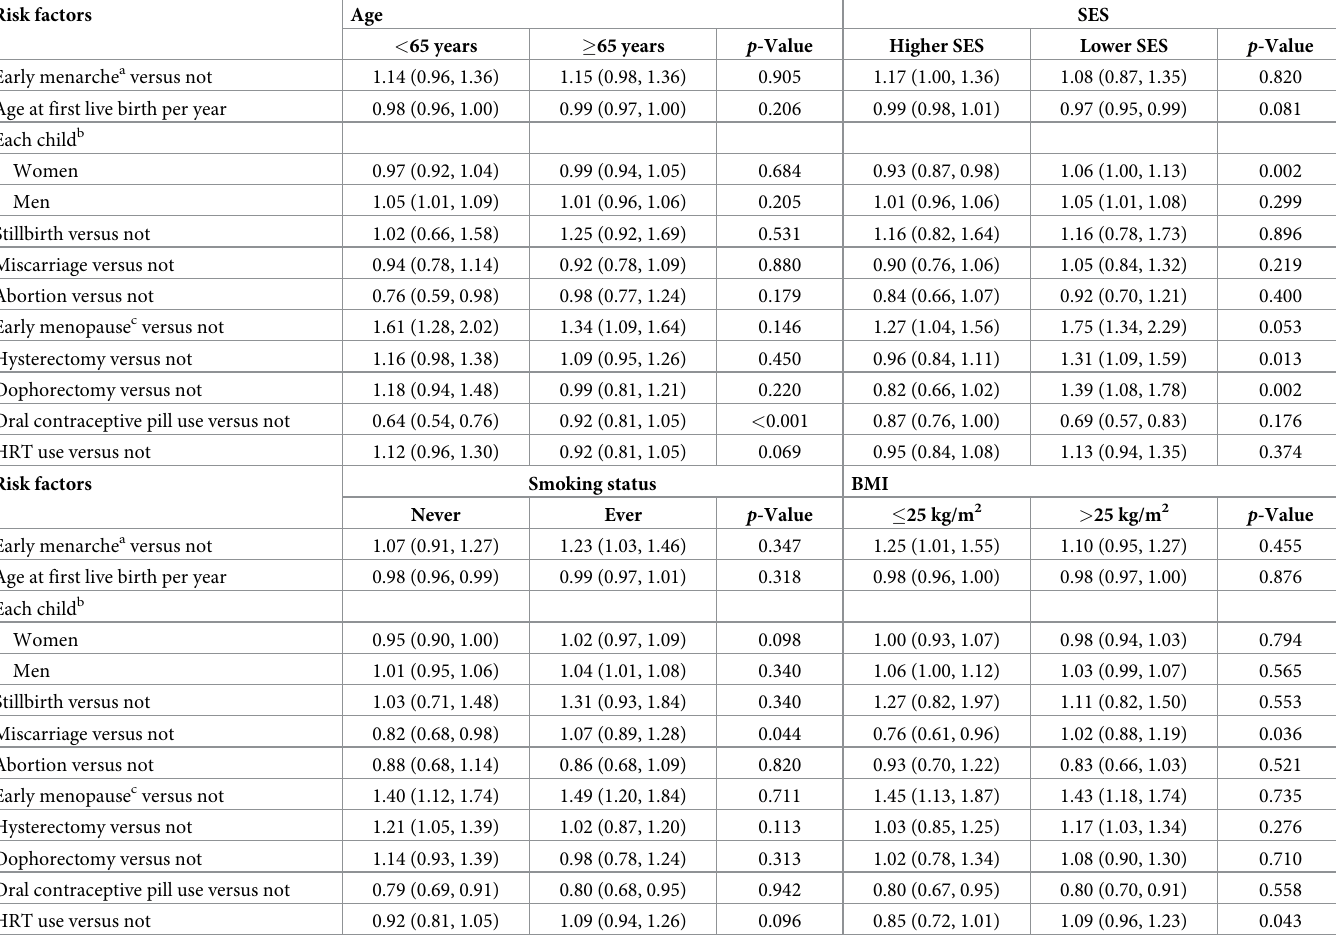
Table 4. Multiple adjusted HRs for the risk of dementia associated with reproductive factors, by age, SES, smoking, and